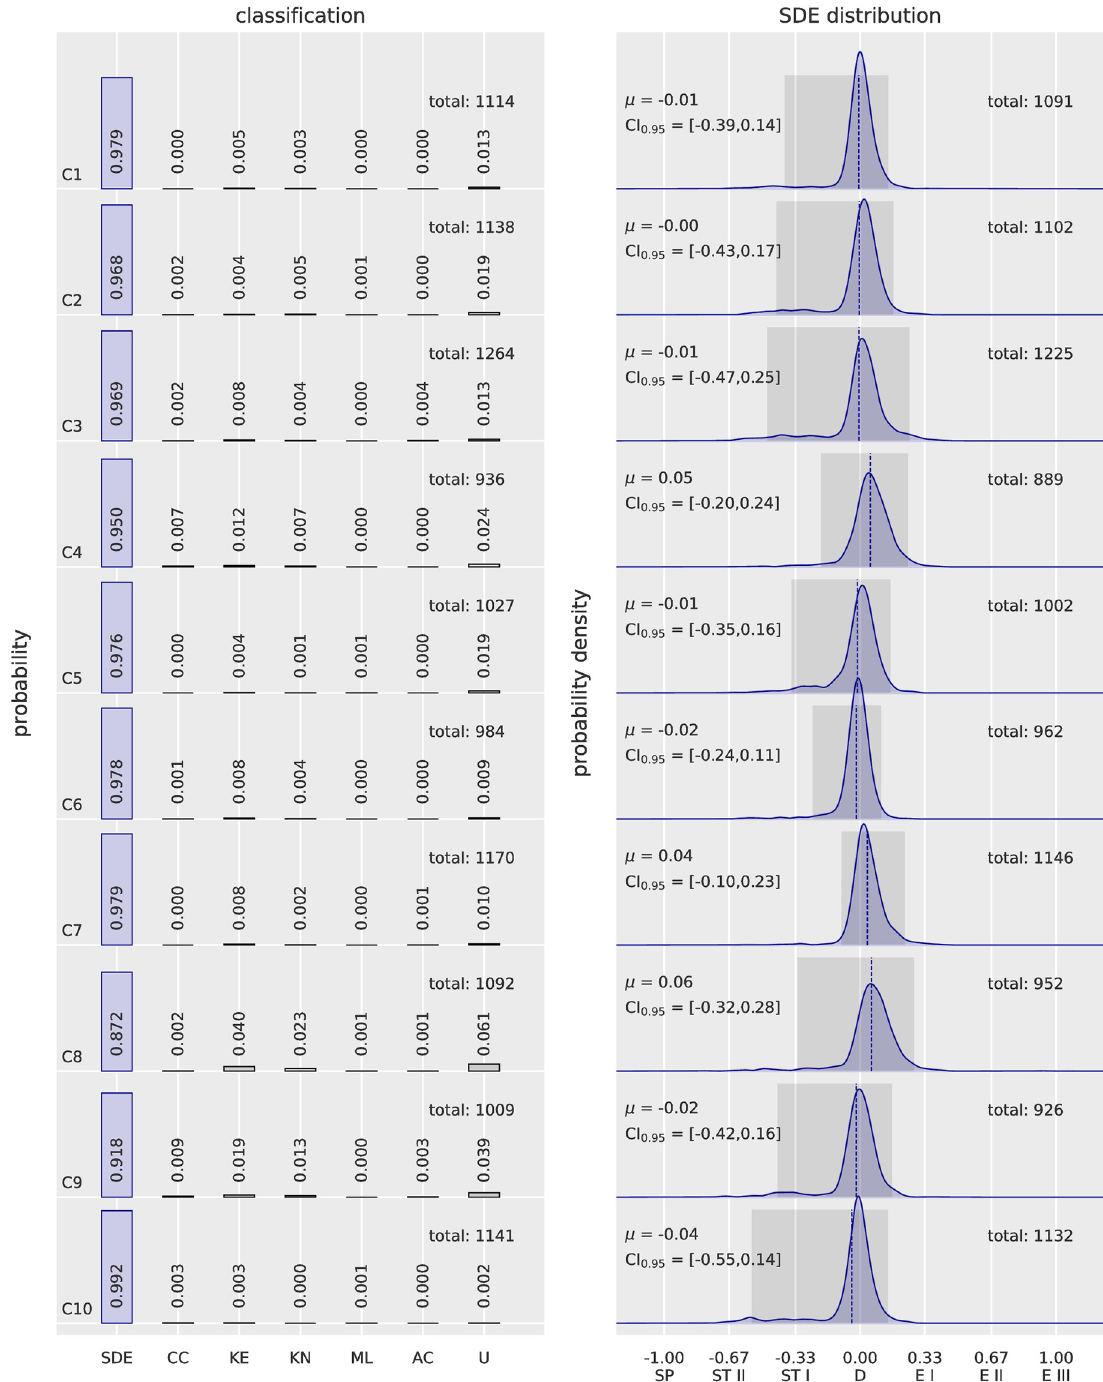
Fig 4. Automatic 3D shape recognition of RBCs from 10 healthy subjects. The total number of analyzed cells per patient is indicated on top right of the classification bar graph. As expected, in healthy individuals, shape distributions are centered around discocytes (0.00), with expected values μ (dashed line in diagrams) ranging from − 0.04 to +0.06. The 95% confidence interval (CI 0.95 , dark grey area) demonstrates that shape distributions do not involve echinocytes, except for C8, which extends to the range of echinocytes I (+0.33). A very small amount of stomatocyte I exists in samples from most donors. The vast majority of cells are identified as “SDE shapes” (see total number in the classification panel versus total in the SDE distribution). The classification ANN contains a small percentage of cells classified as unknown. These results support the reproducible outcome of the dual-stage ANN analysis of RBCs from different donors and corroborate the differences seen between patients.